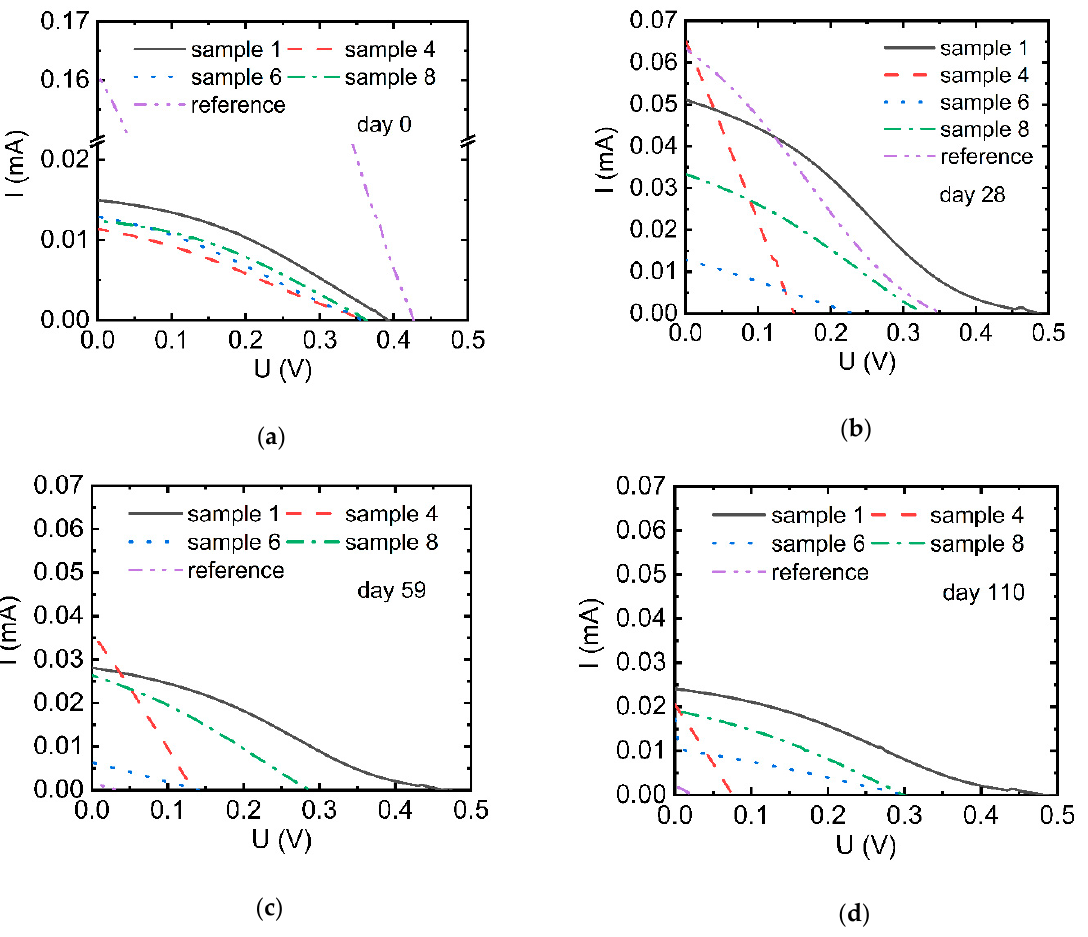
Figure 7. I-U curves of PAN blended with PEO (sample 1), ABS blended with PEO (sample 4), PVA blended with PEO (sample 6), PVDF blended with PEO (sample 8) GPEs and a reference for: ( a ) day 0; ( b ) day 28; ( c ) day 59; and ( d ) day 110.